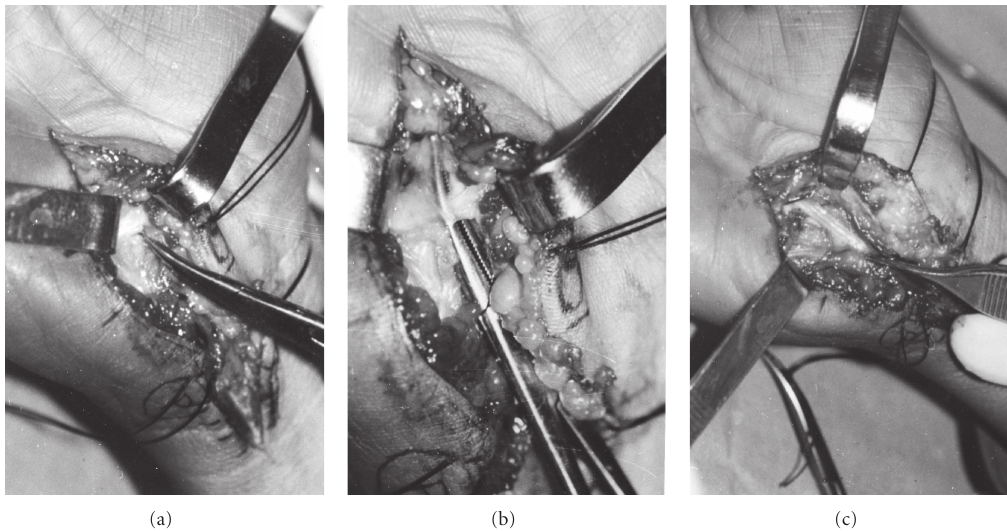
Figure 1: A thick fibrous band crossing over the motor branch of the ulnar nerve was identified at the middle portion of Guyon’s canal (indicated by the haemostat) (a) and (b). After the resection of the fibrous band, the deep motor branch of the ulnar nerve appeared decompressed (c).